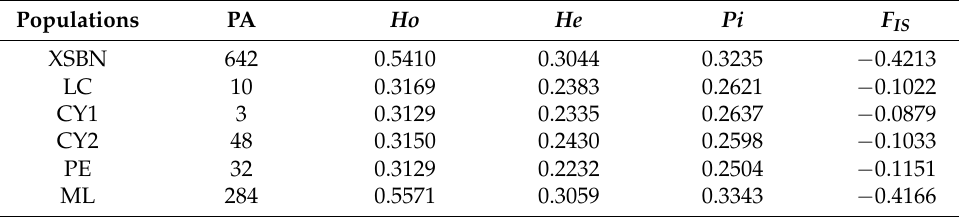
Table 2. Genetic diversity parameters for T. doichangensis populations based on GBS. Populations PA Ho